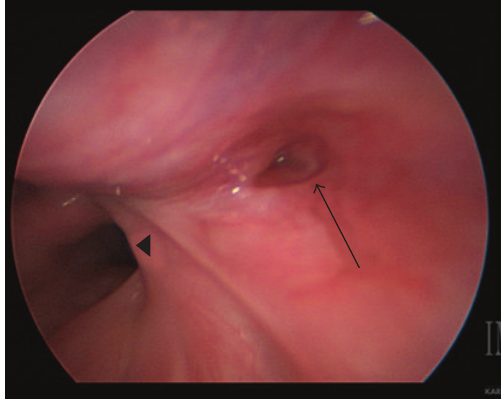
Figure 2: Fistulous tract (arrow) visualized in the right pyriform sinus adjacent to esophagus